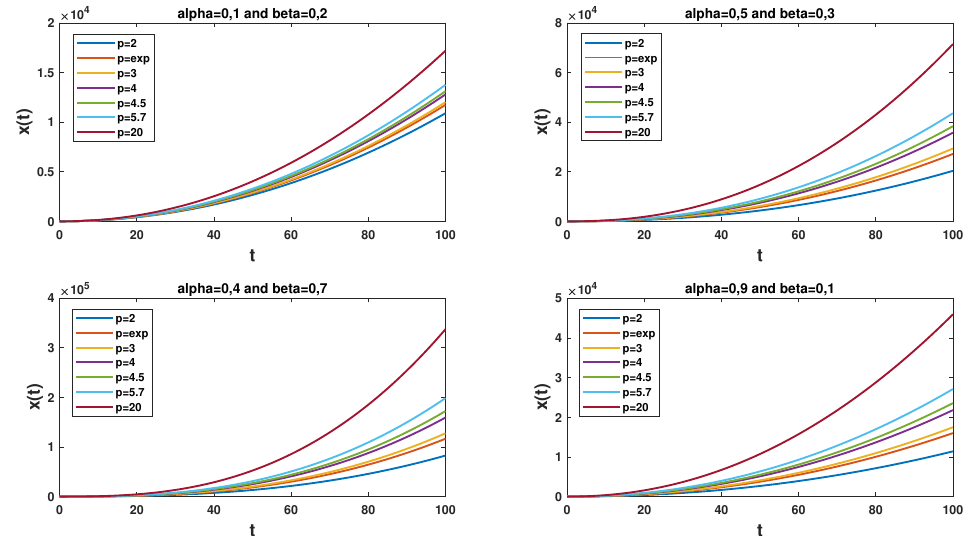
Figure 1. Impact of the power parameter p on the solution x ( t ) (19) of problem (18) of Example 1 with different values of orders α and β